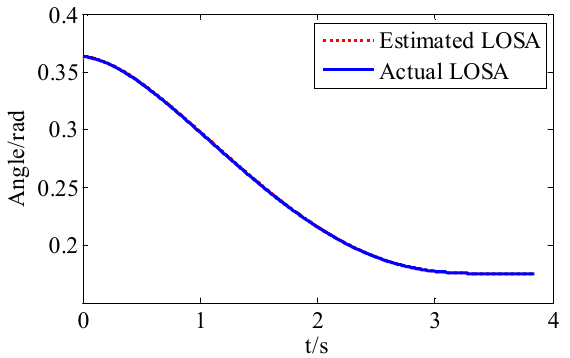
Figure 7. High-order tracking differentiator (HTD) estimation.